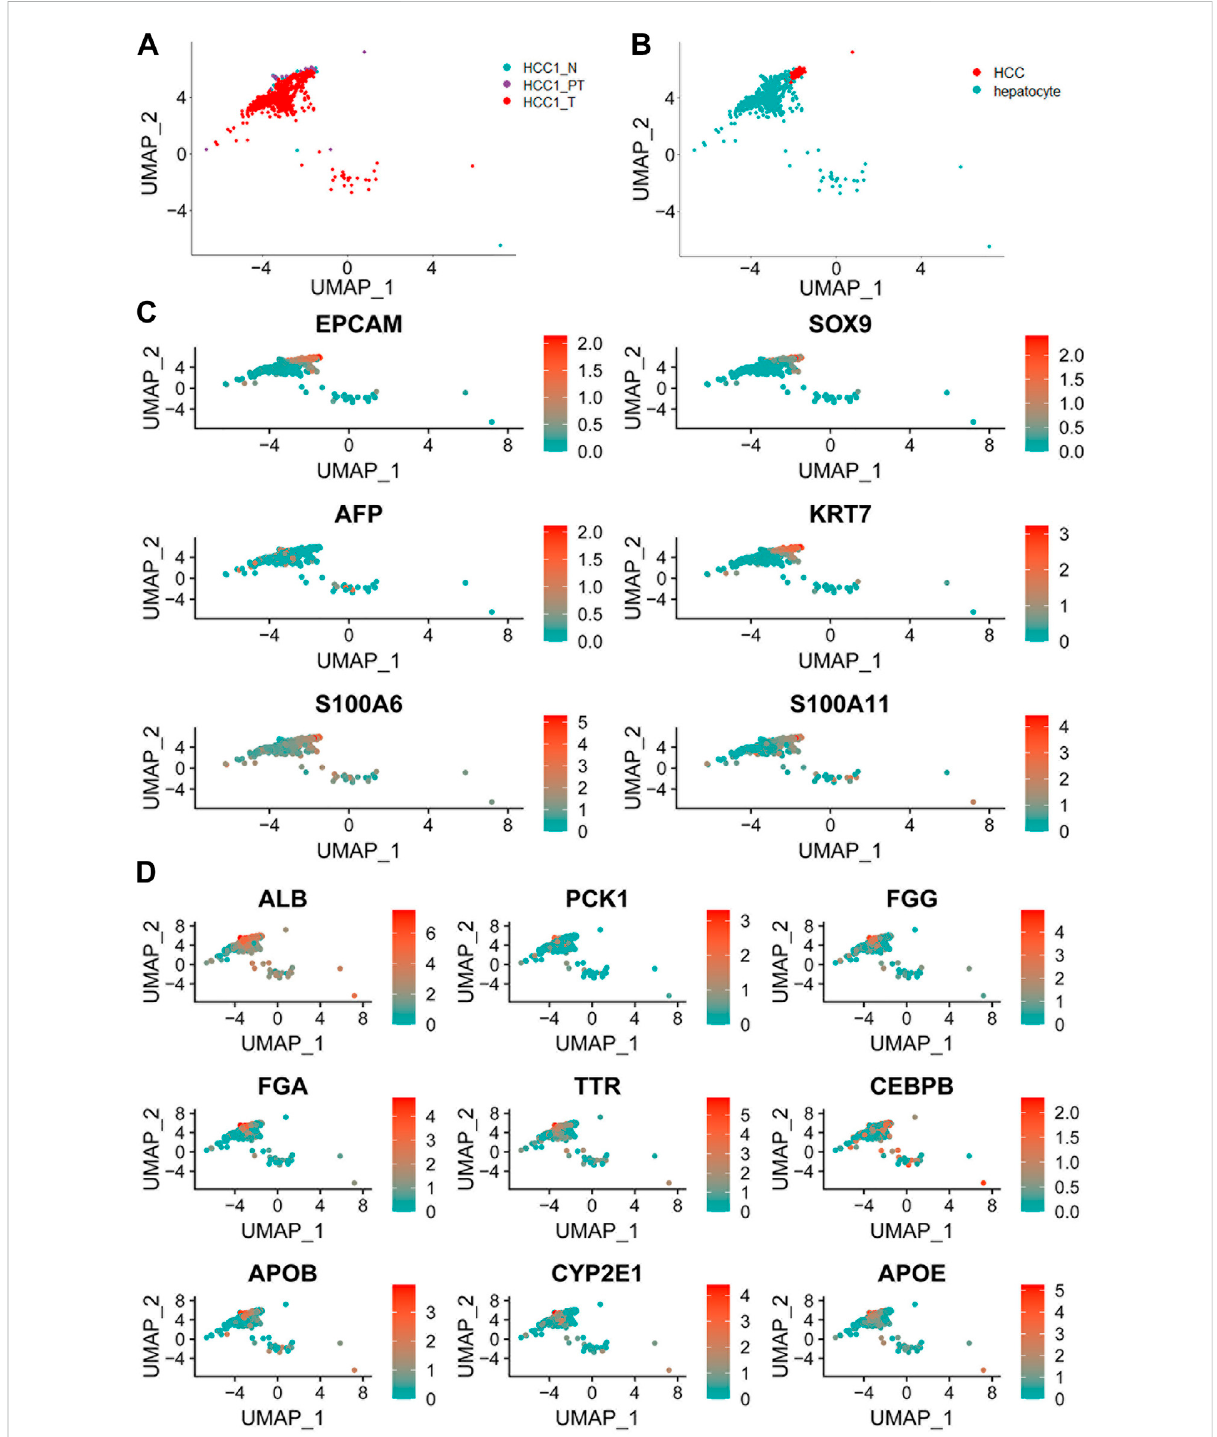
FIGURE 3 Distribution ofhepatic cells indifferenttissue samples. (A) UMAP plotshowing atotalof 952liver cells indifferent tissue samples; (B) UMAPplot of all hepatocytes including normal hepatocytes and hepatocellular carcinoma cells; (C) UMAP plot of liver cancer cell markers based on known lineage-speci fi c marker genes ( EPCAM , SOX9 , AFP , KRT7 , S100A6 , and S100A11 ); and (D) UMAP plot of normal liver cell marker genes ( ALB , PCK1 , FGG , FGA , TTR , CEBPB , APOB , CYP2E1 , and APOE